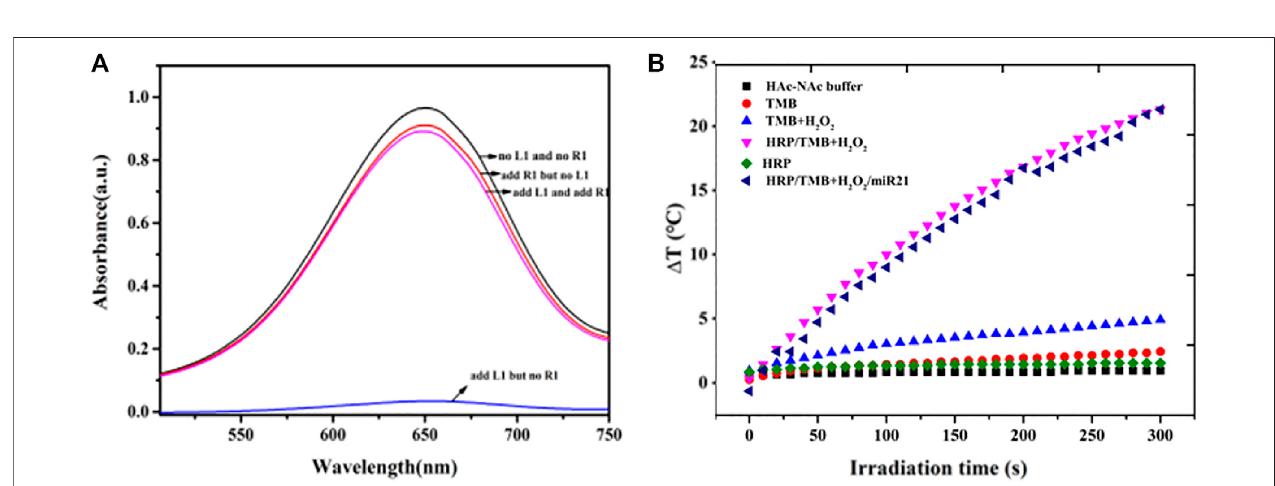
FIGURE 2 | (A) Feasibility test of the release of HRP in hydrogels based on the intensity of absorption peak of oxTMB at 650 nm (B) Photothermal evolution of different components including HAc-NaAc buffer, TMB, TMB-H 2 O 2 , HRP, HRP-TMB-H 2 O 2 under 808 nm laser at a power density of 5.26 W cm − 2 for 300 s.